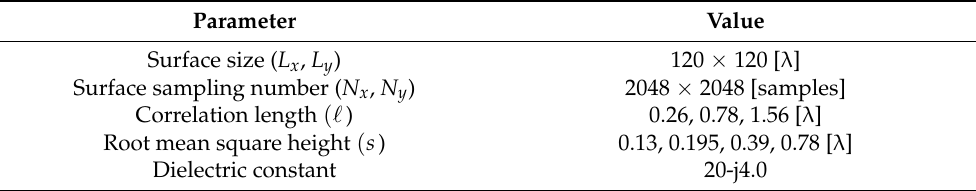
Table 2. Surface